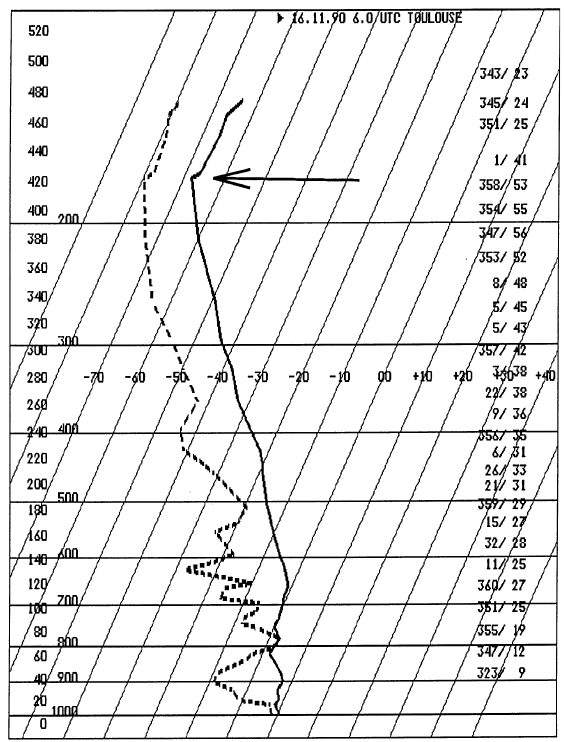
Fig. 10. The same as Fig. 8, but for 16 November at